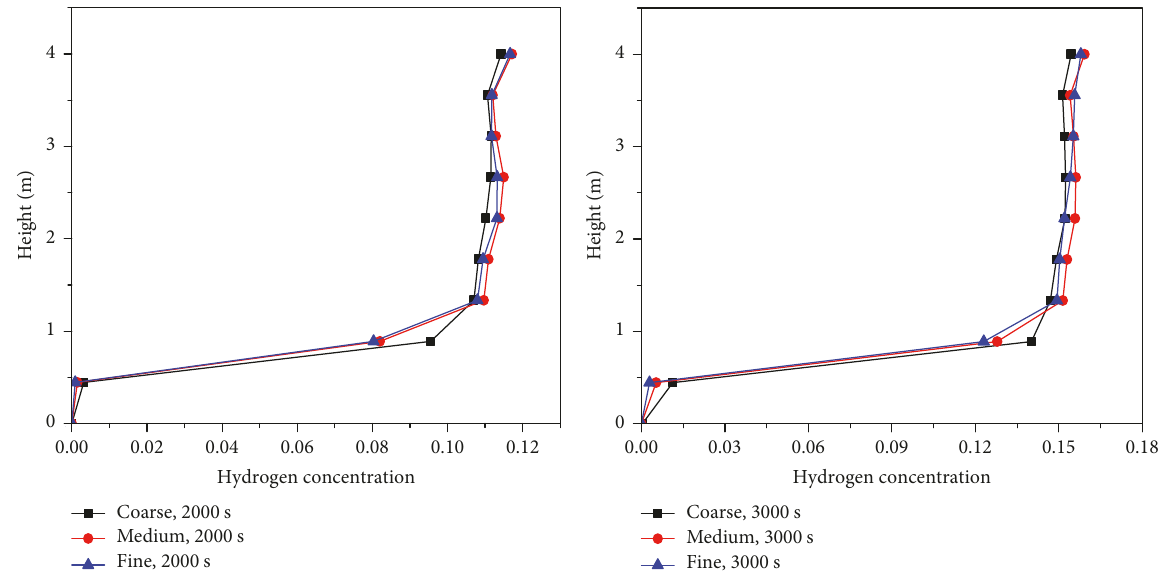
Figure 5: Hydrogen distribution for mesh sensitivity on line 1 in source term compartment of case 1 .